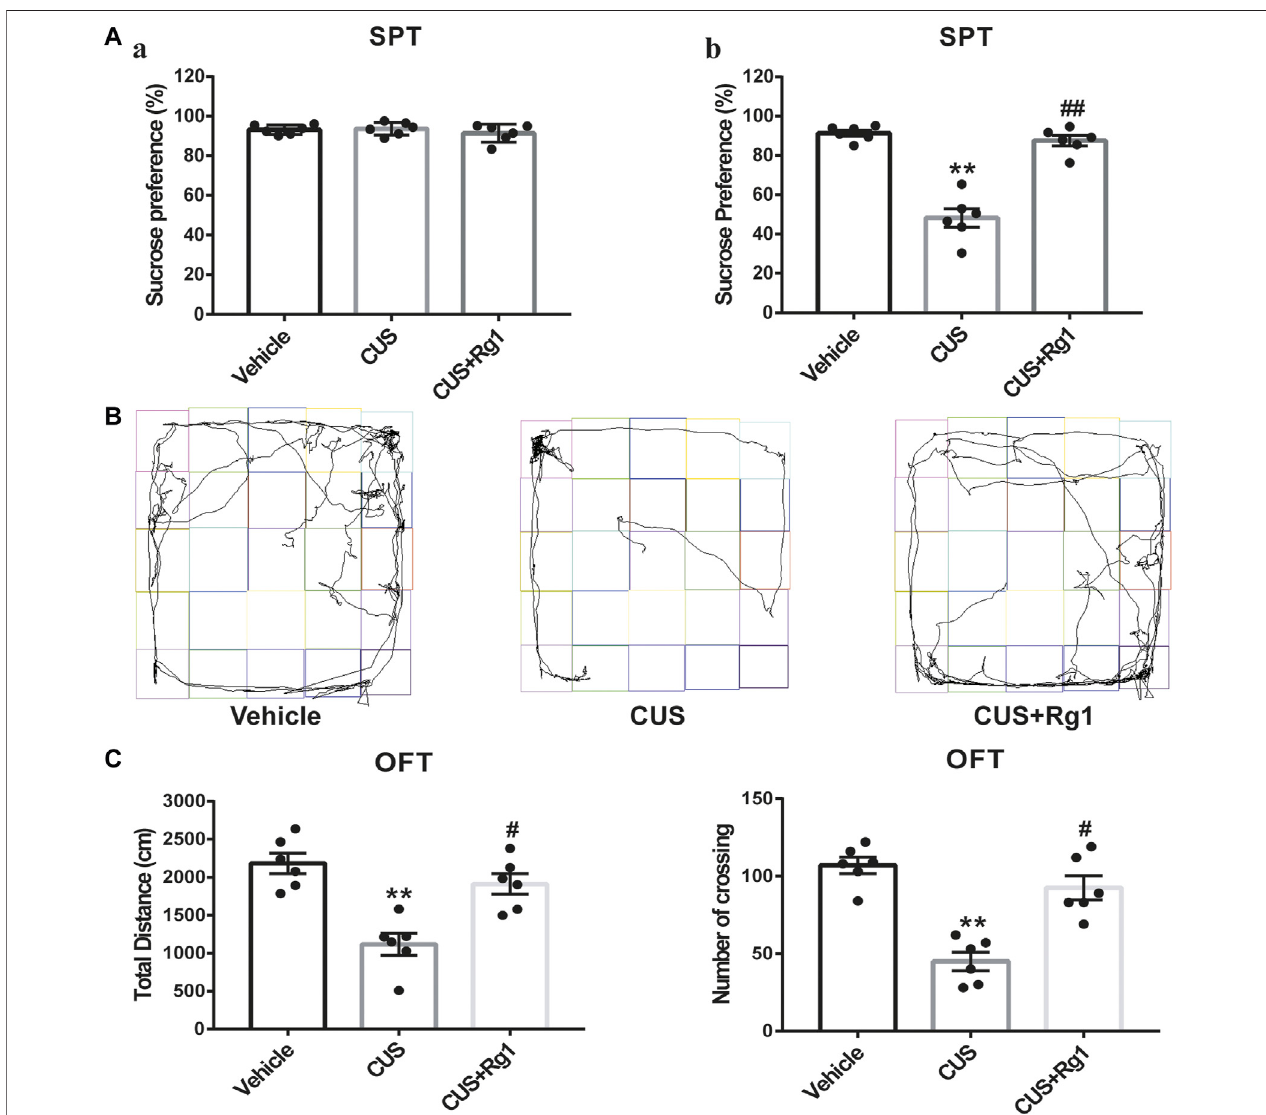
FIGURE 2 | Rg1 attenuates depression-like behaviors induced by CUS exposure in rats. (A) The sucrose preference of rats was similar to each group before the CUS procedure (a); treatment with Rg1 prevented the decreased sucrose preference in CUS rats (b). (B) Representative images of the route traveled of rats in each group. (C) Rg1 treatment reversed the decreases in total distance and number of crossing of CUS-exposed rats in the OFT. One-way ANOVA followed by Tukey ’ s multiplecomparisonstest.Allvaluesarerepresentedasmean ± SEM( n (cid:1) 6).** p < 0.01,comparedwiththevehiclegroup; ## p < 0.01and # p < 0.05,comparedwith the CUS